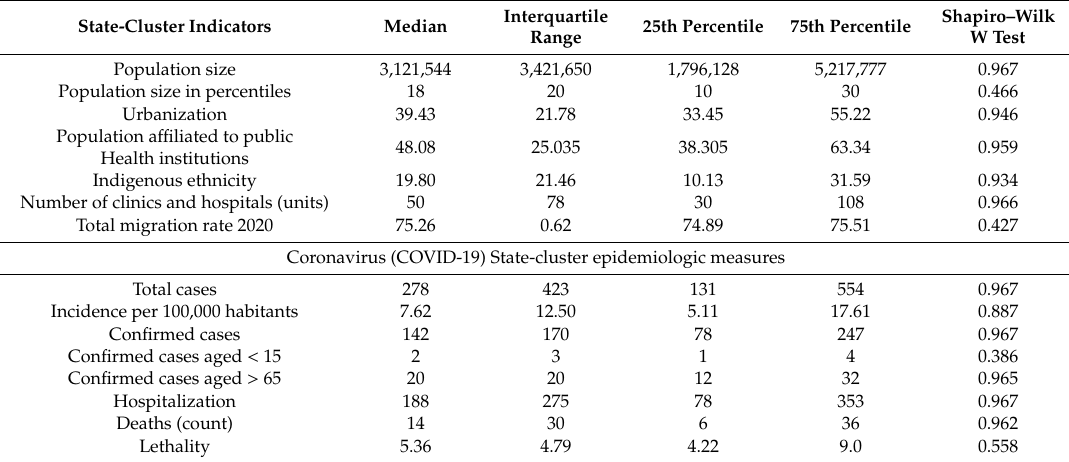
Table 1. Descriptive statistics of Coronavirus (COVID-19) state-clusters ( n = 32 states) in